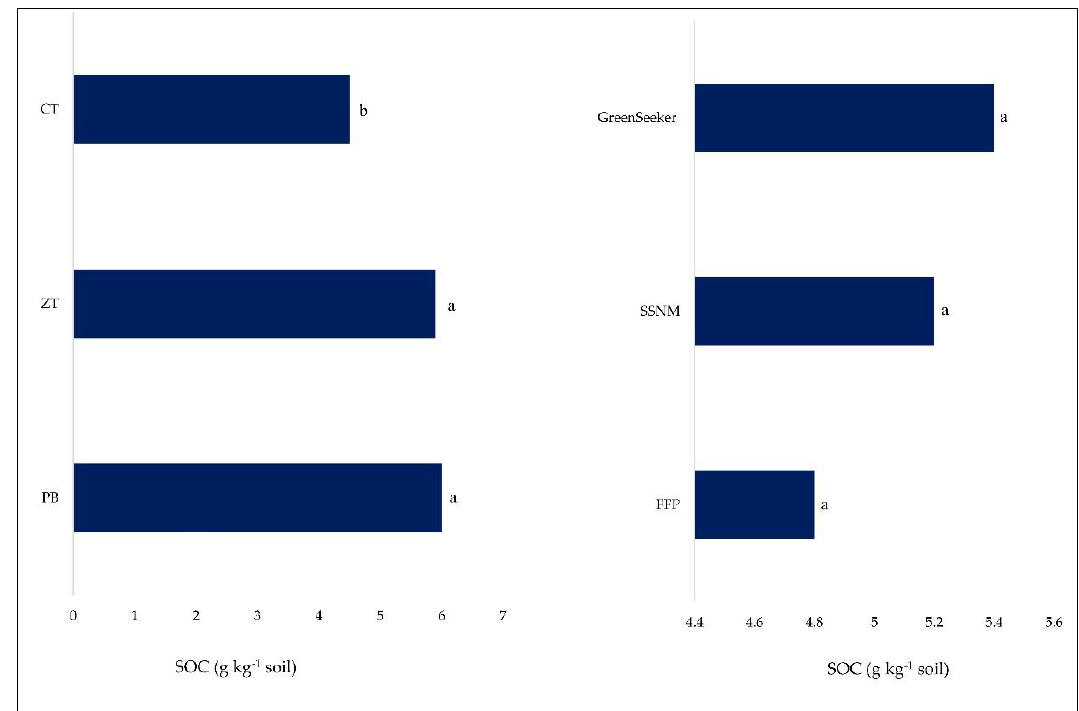
Figure 3. Soil organic carbon (SOC) under different long-term tillage practices and nutrient management options [same letters after bars represent no statistical difference ( p ≤ 0.05); CT, ZT, and PB denote conventional tillage, zero tillage/direct seeding, and permanent bed, respectively; SSNM, and FFP denote site-specific nutrient management using Nutrient Expert Software, and farmers’ practice, respectively].